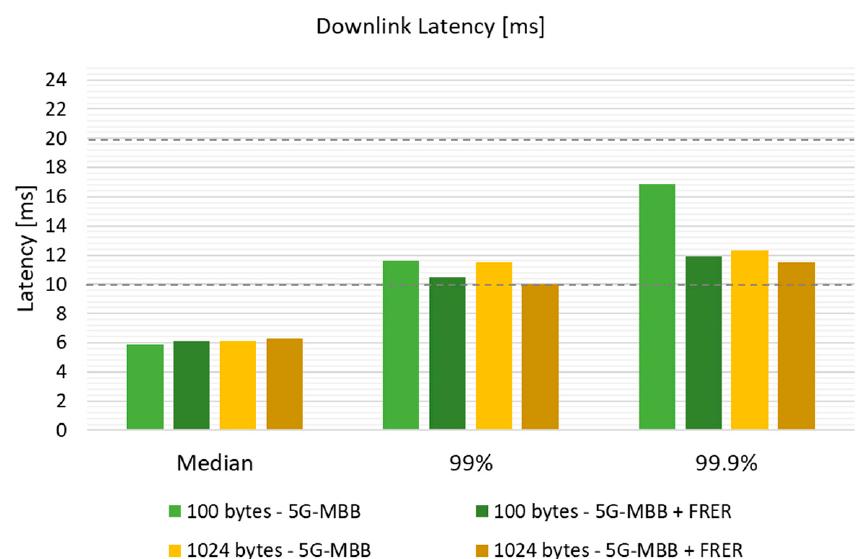
Figure 10. Downlink latency with and without redundant transmissions using FRER.